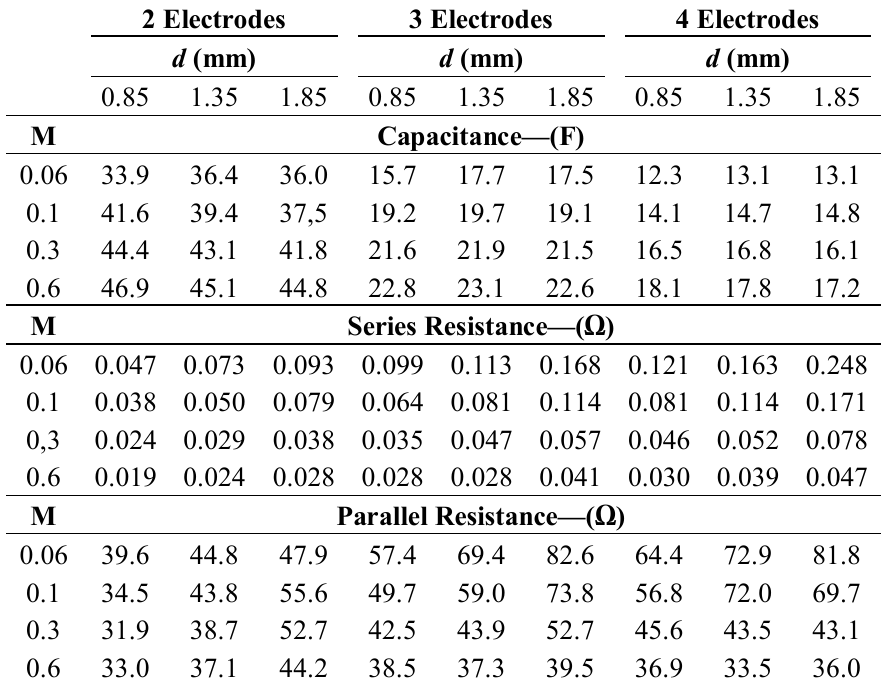
Table 1. CDI cell parameters for different geometrical configurations. 2